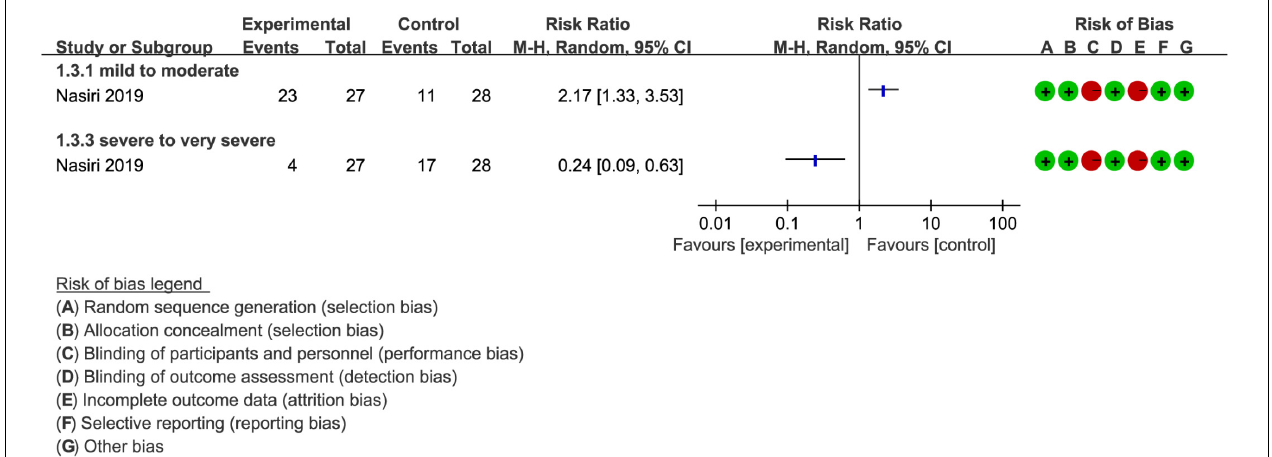
FIGURE 5 | The incidence of different levels of severity after